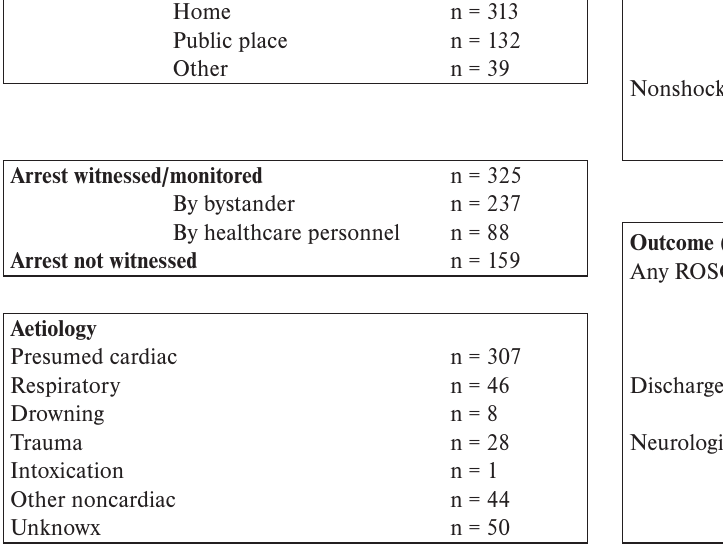
Fig. 1. Utstein flowchart of 2018 OHCA events where CPR is commenced or continued by EMS in Pilsen Region.